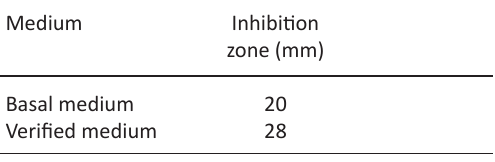
Table 5. A verification experimental: antagonistic